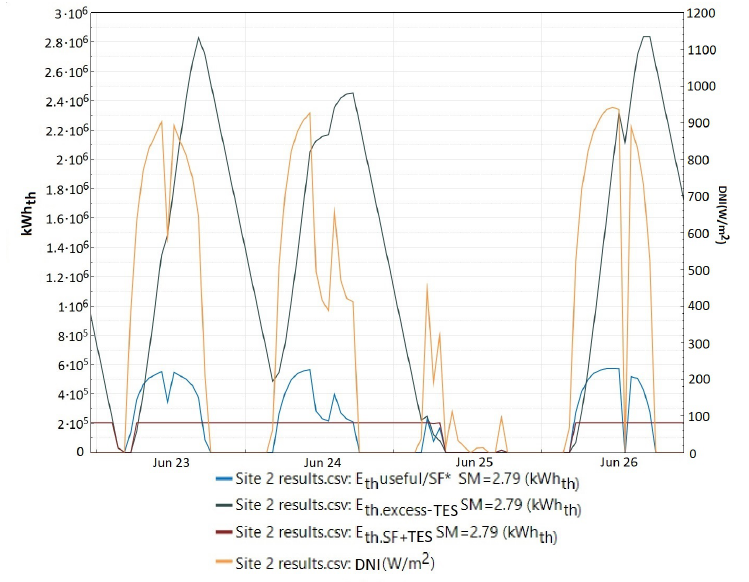
Figure 7. Evolution of the main simulated thermal variables in the presence of moderate and aggressive DNI transients—site 2